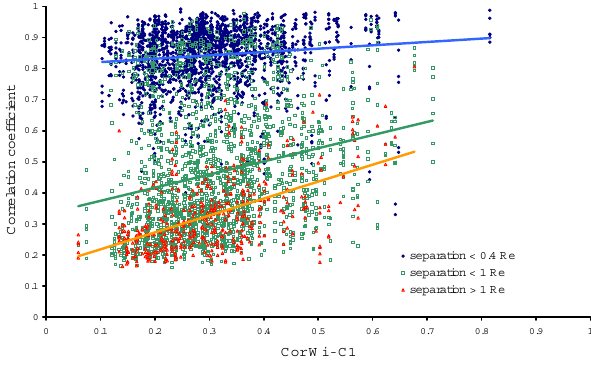
Fig. 12. A scatter plot of standard deviations of C2, C3, and C4 magnetic field measurements as a function of standard deviations of C1 measurements for three groups of s/c